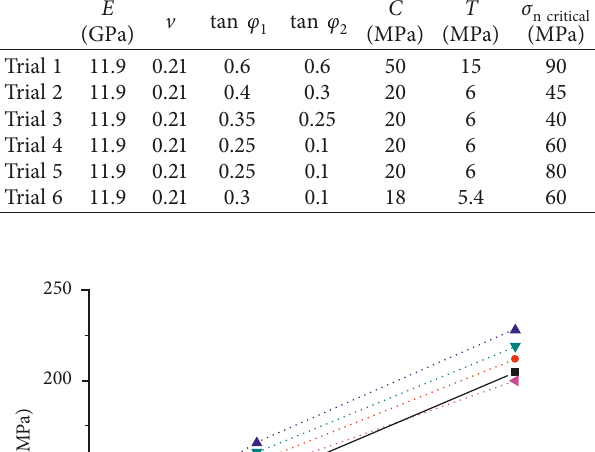
Table 1: Macromechanical parameters of materials in Tien et al.’s experiment [6].